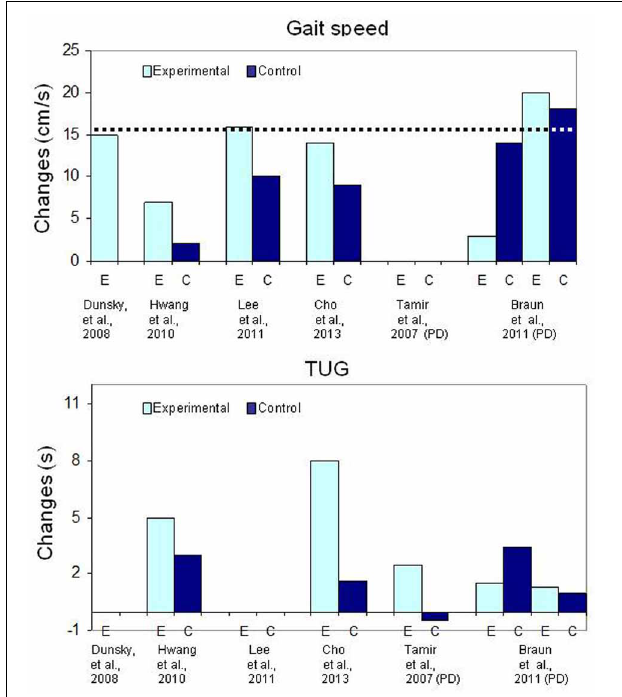
FIGURE 3 | Bar graph illustrating the mean changes (cm/s) in gait speed (upper graph) and the mean changes (in seconds) for the Timed Up and Go (TUG) test in patients with chronic stroke. The dotted line (upper graph) indicates the Minimal Clinically Important Difference.